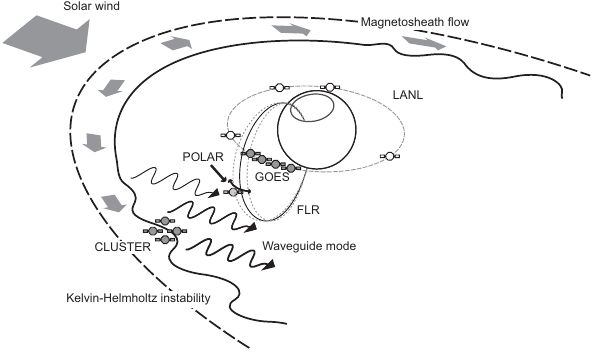
Fig. 1. A schematic representation of the results reported in R05. This schematic is shown from the post-dusk sector above the equa- torial plane, with the sun and solar wind in the top left hand corner, and the magnetotail stretching in the bottom right direction.